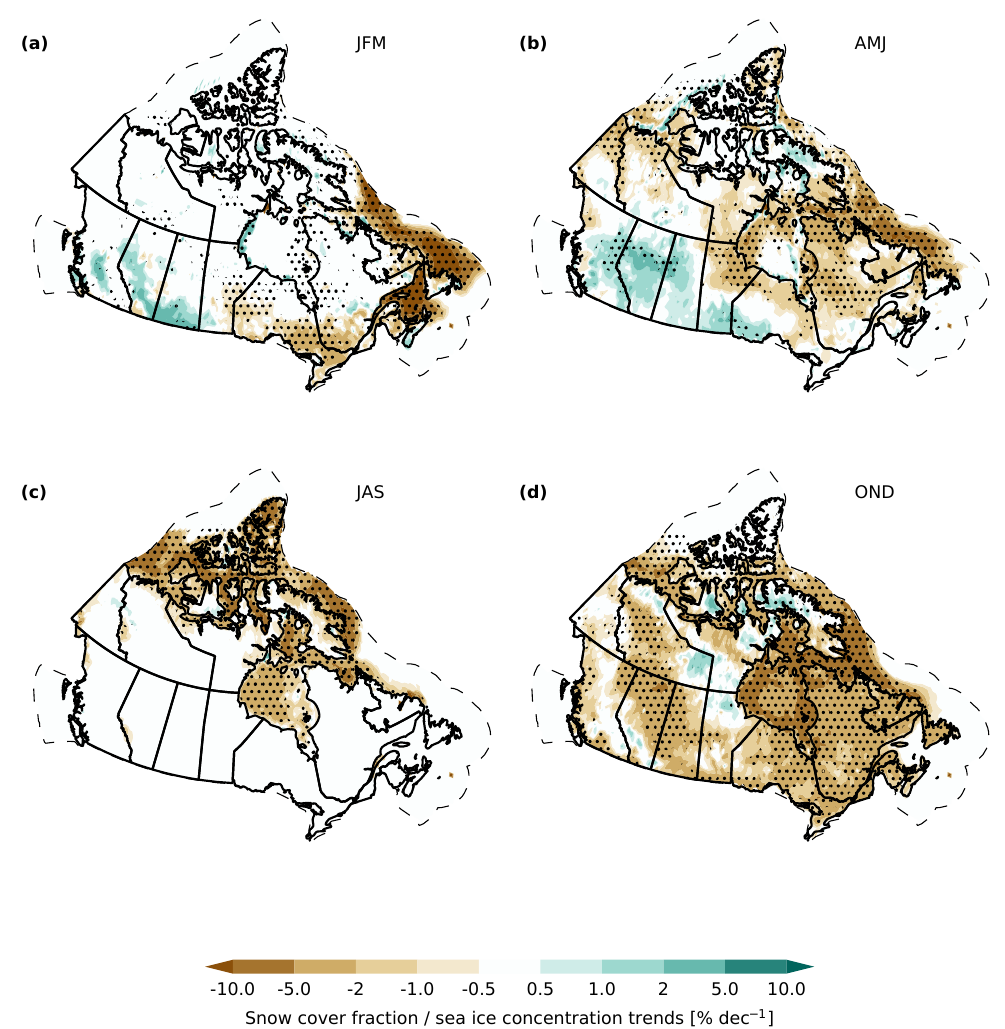
Figure 1. Terrestrial snow cover fraction and sea ice concentration trends for 1981–2015. Datasets are described in Sect. 2.1. Stippling indicates pointwise significance at the 90th percentile. Dashed line denotes limit of Canadian marine